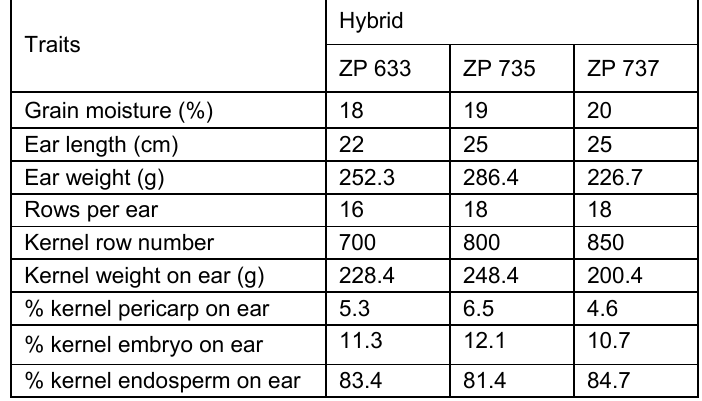
Table 7 – Whole plant silage yield depending on the maize hybrid sowing